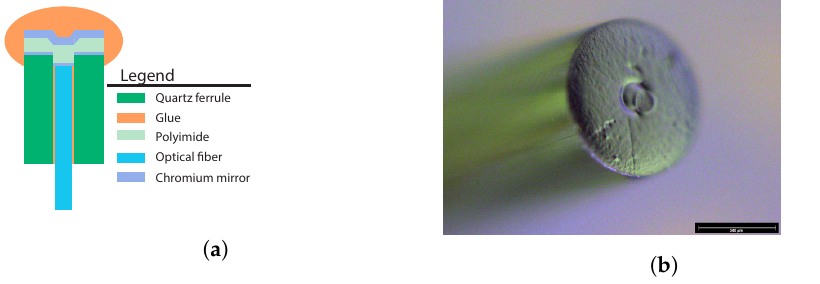
Figure 6. ( a ) Sketch of the cross-section of the thin-film concept. ( b ) Close up image of the proof-of-concept of the thin-film device, after deposition of the last 100 nm thick chromium layer. A small particle seems to be partially covering the optical fiber located in the center of the